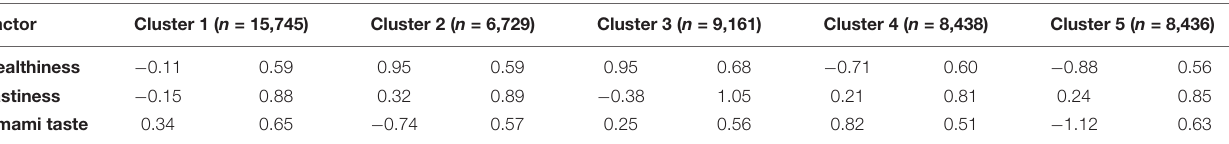
FIGURE 8 | Cluster analysis of stimulus set foods based on latent factor scores. Three latent factor scores (reflecting healthiness, tastiness, and umami taste) were calculated for each food item in each participant’s set, using Thomson’s regression method and ratings for each of the 17 rated attributes. Average factor scores for each food could then be calculated across participants. (A) Foods were clustered into five categories based on their average factor scores. (B) Examples of food items within each cluster. (C) Mean factor scores for each cluster of foods were calculated, using all participant data (i.e., 46 data points for each factor, for each of the 1,054 participants), demonstrating the five clusters varied on the latent dimensions of healthiness, tastiness, and umami taste. TABLE 2 | Mean factor scores for foods in each